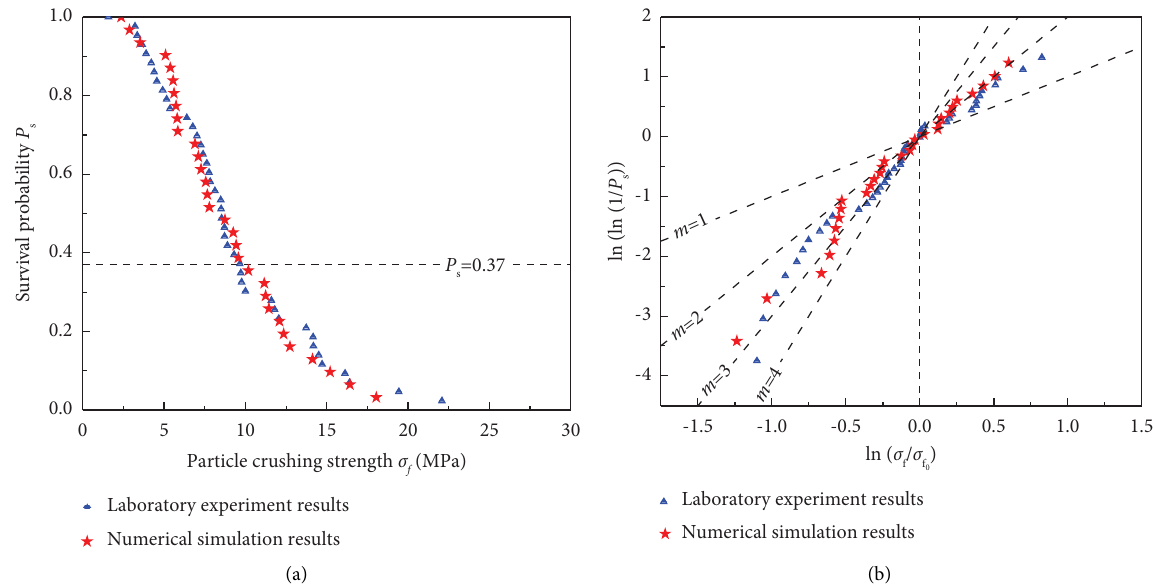
Figure 4: Comparison of the survival curves obtained via the numerical and laboratory particle breakage tests. (a) Survival probability curves, (b) normalized survival probability curves.